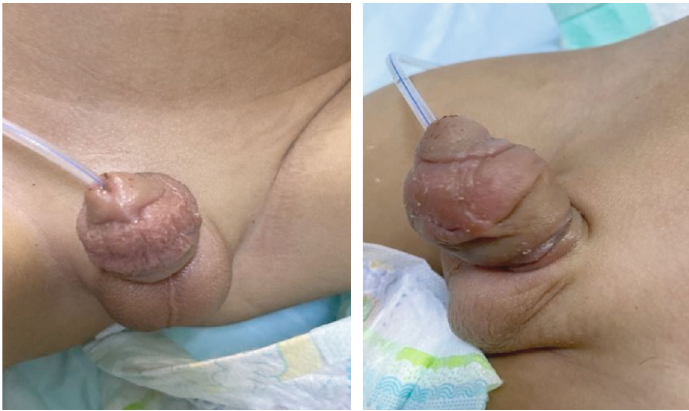
Figure 2: Postoperative day three with the catheter in